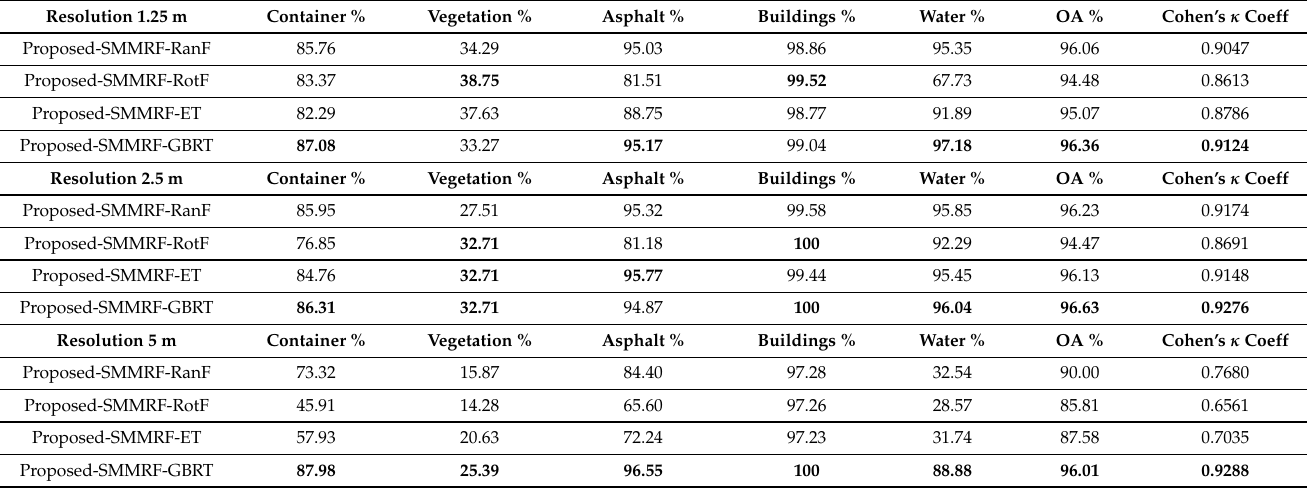
Table 5. “Haiti” dataset: test-set class-wise accuracies of the proposed SMMRF-based method as a function of the adopted decision tree